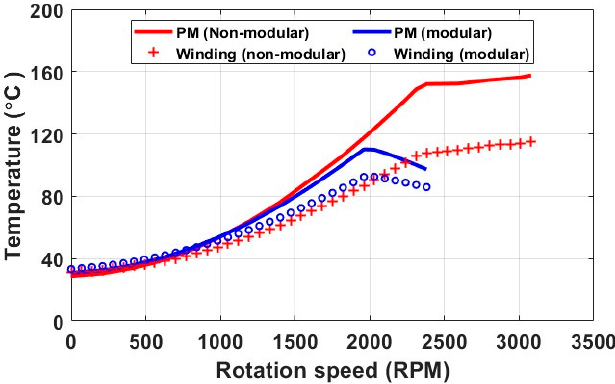
Figure 9. Magnet and winding temperature speed curves of modular and non-modular machines.